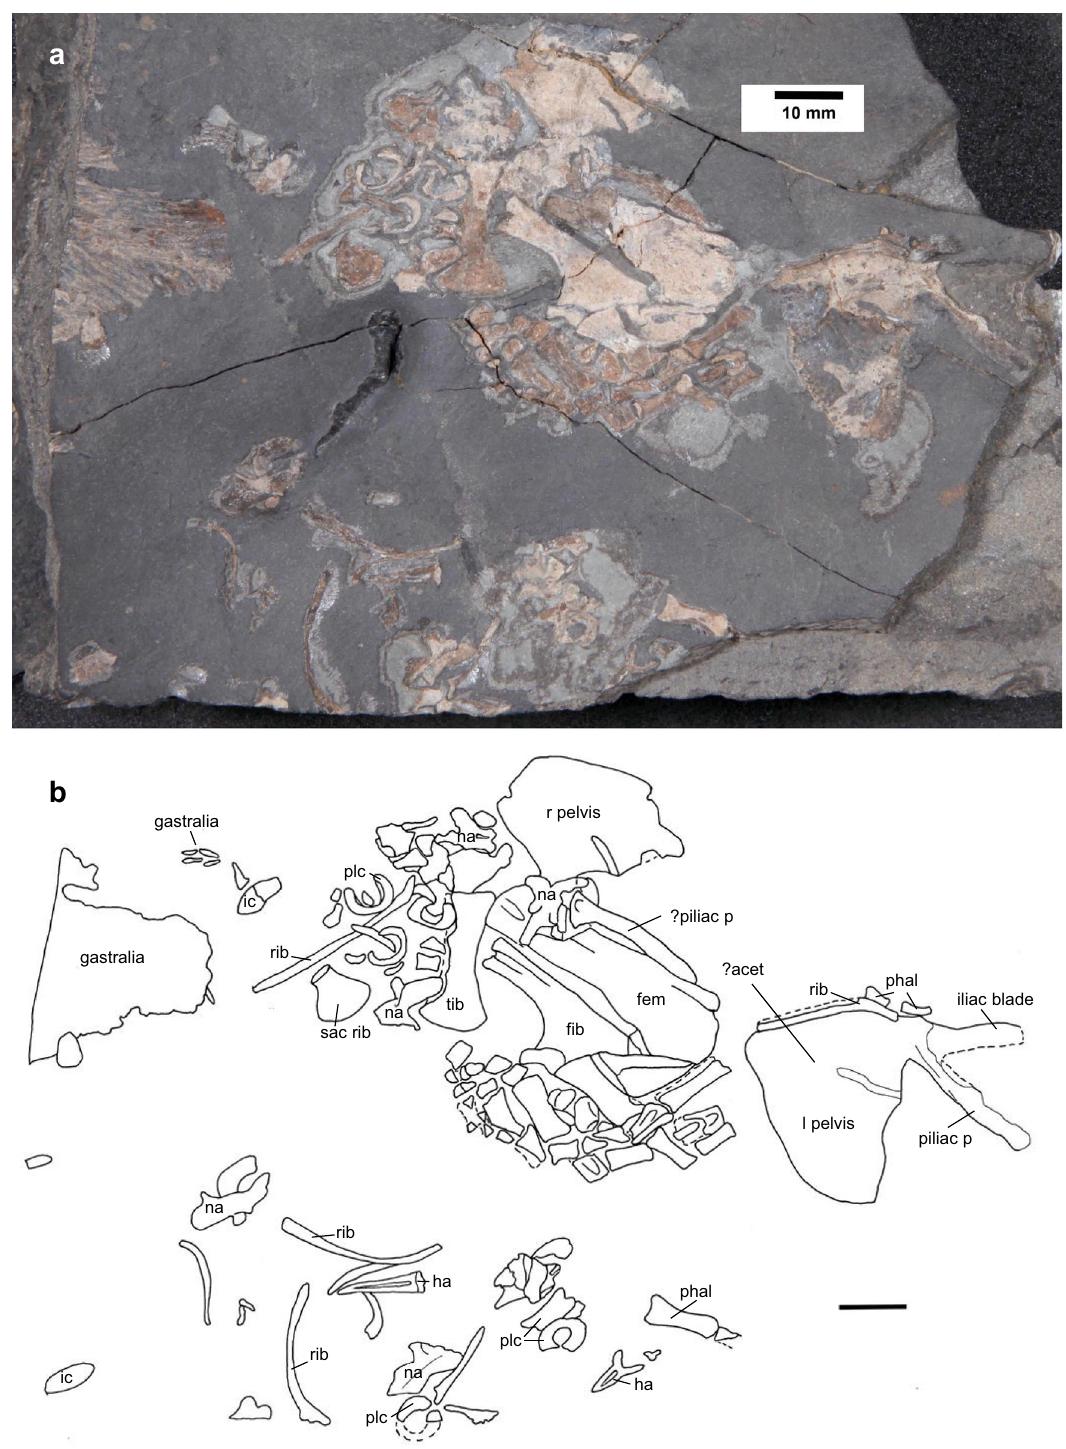
Fig. 1 Termonerpeton makrydactylus gen. et sp. nov. holotype UMZC 2019.1. a Specimen photograph. b Interpretive drawing. Scale bars 10 mm. Abbreviations: acet acetabulum, fem femur, fi b fi bula, ha haemal arch, ic intercentrum, l left, na neural arch, phal phalanx, piliac p post-iliac process, plc pleurocentrum, r right, sac rib sacral rib, tib